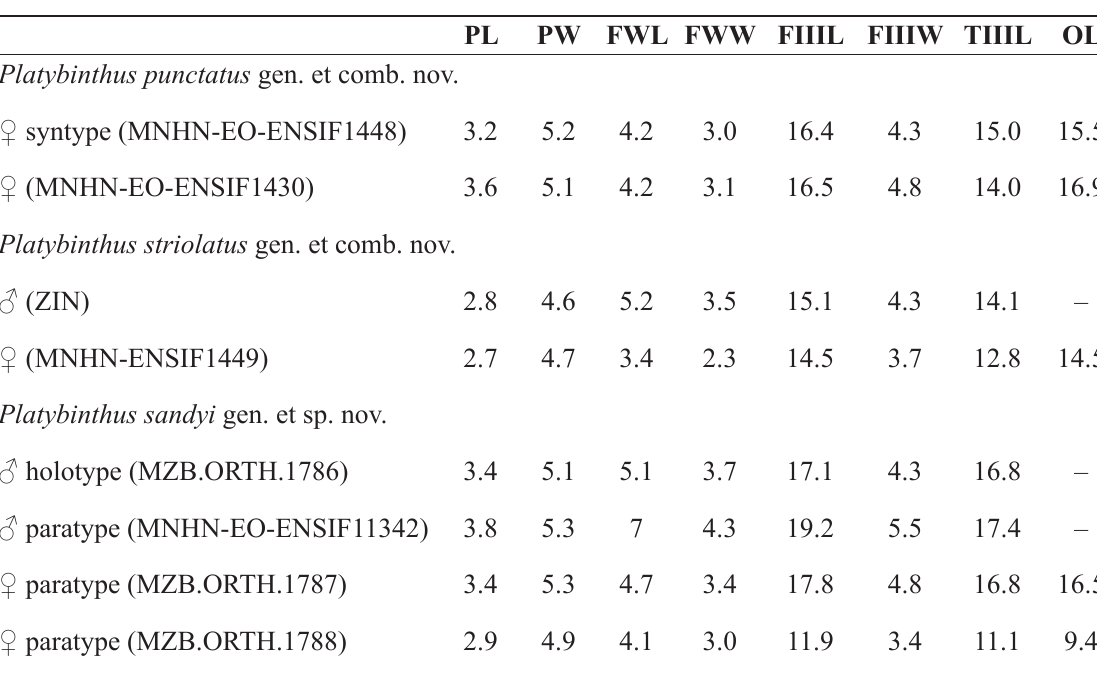
Table 1. Measurements of Platybinthus gen. nov. (in